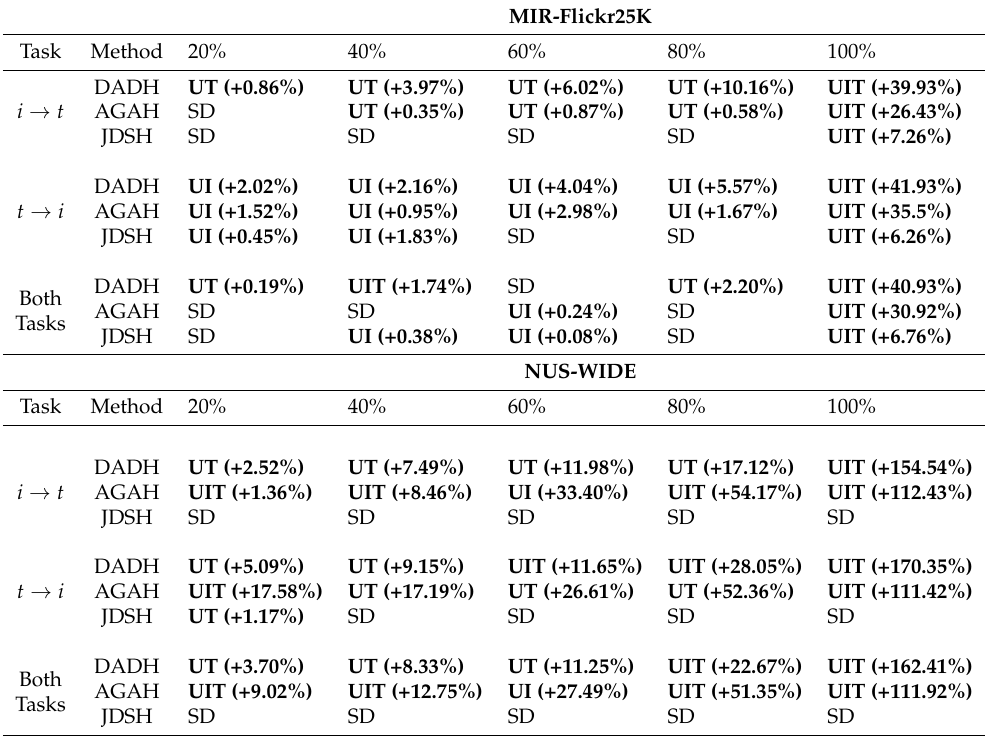
Table 7. The sampling cases that produced the best retrieval results are indicated by UI: Unpaired Image, UT: Unpaired Text, UIT: Unpaired Image and Text, and SD: Sample discarding. The percentage shown in the brackets is the performance difference by which a given unpaired sample case (shown in Tables 3–5) outperformed sample discarding (SD) (shown in Table 6). The first row shows the percentage of training samples being unpaired (UI, UT, UIT), or discarded (SD) depending on